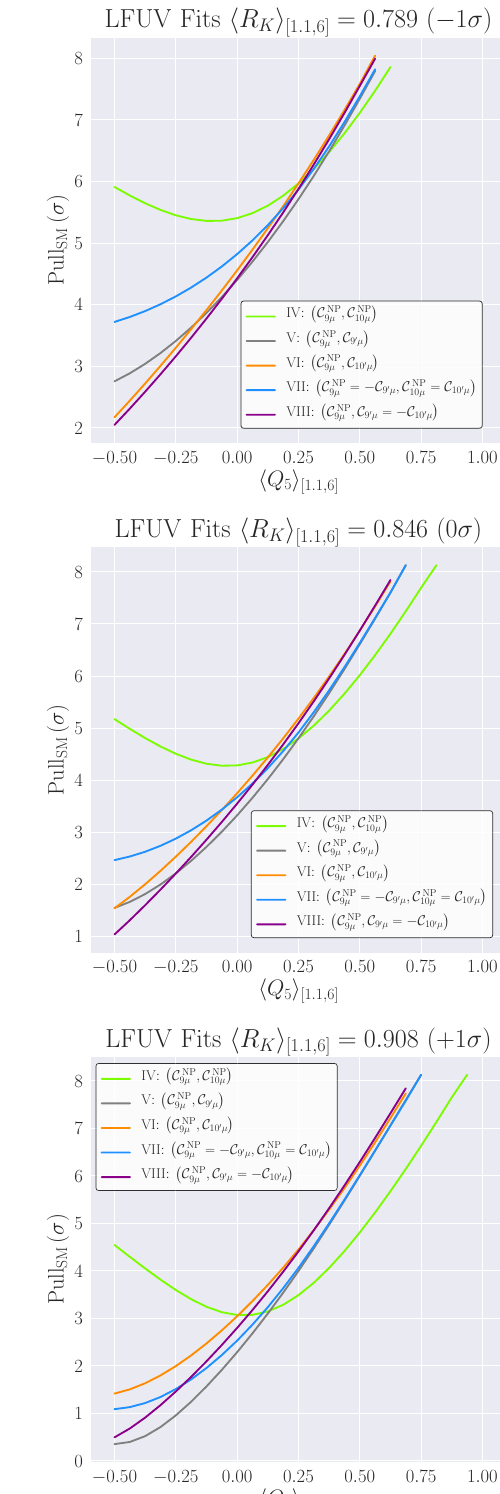
Figure 8. LFUV fit: impact of NP hypotheses under